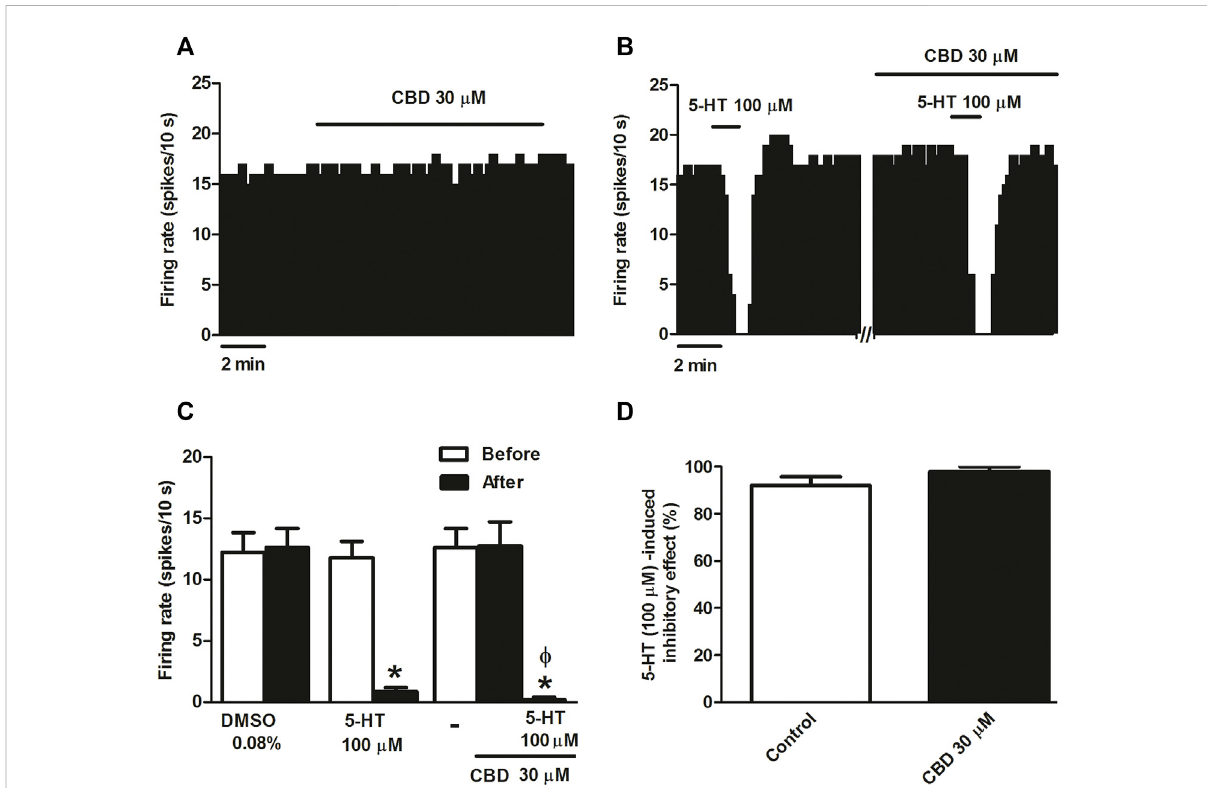
FIGURE 1 Effect ofCBD on the fi ring rateof DRN5-HT cells andon 5-HT-inducedinhibition. (A,B) Representative examples of fi ring raterecordings from two DRN cells, which show the effect of CBD (30 μ M) on the fi ring activity of 5-HT neurons (A) and the effect of CBD (30 μ M) on 5-HT (100 μ M)- induced inhibition (B) . Vertical lines refer to the integrated fi ring rate values (spikes per 10 s) and the horizontal lines represent the time scale. Drugs were perfused at the concentration and for the time indicated by the horizontal bars. ACSF was applied in the continuous presence of the vehicle (DMSO 0.08%). (C) Bar histograms showing the fi ring rate of 5-HT cells (mean ± SEM) before and after perfusion with the vehicle (DMSO 0.08%, n =5),5-HT(100 μ M)( n =5),CBD(30 μ M)( n =5),andCBD(30 μ M)+5-HT(100 μ M)( n =5). (D) Barhistogramsshowingthepercentageof5- HT (100 µM)-induced inhibition from the basal fi ring rate (mean ± SEM) in the absence and presence of CBD (30 μ M) ( n = 5). * p < 0.005 compared withthe fi ringratebeforedrugapplicationbypairedStudent ’ st-test. Φ P < 0.005compared withthe fi ringrateafteradministrationofCBD(30 μ M)in the absence of 5-HT by paired Student ’ s